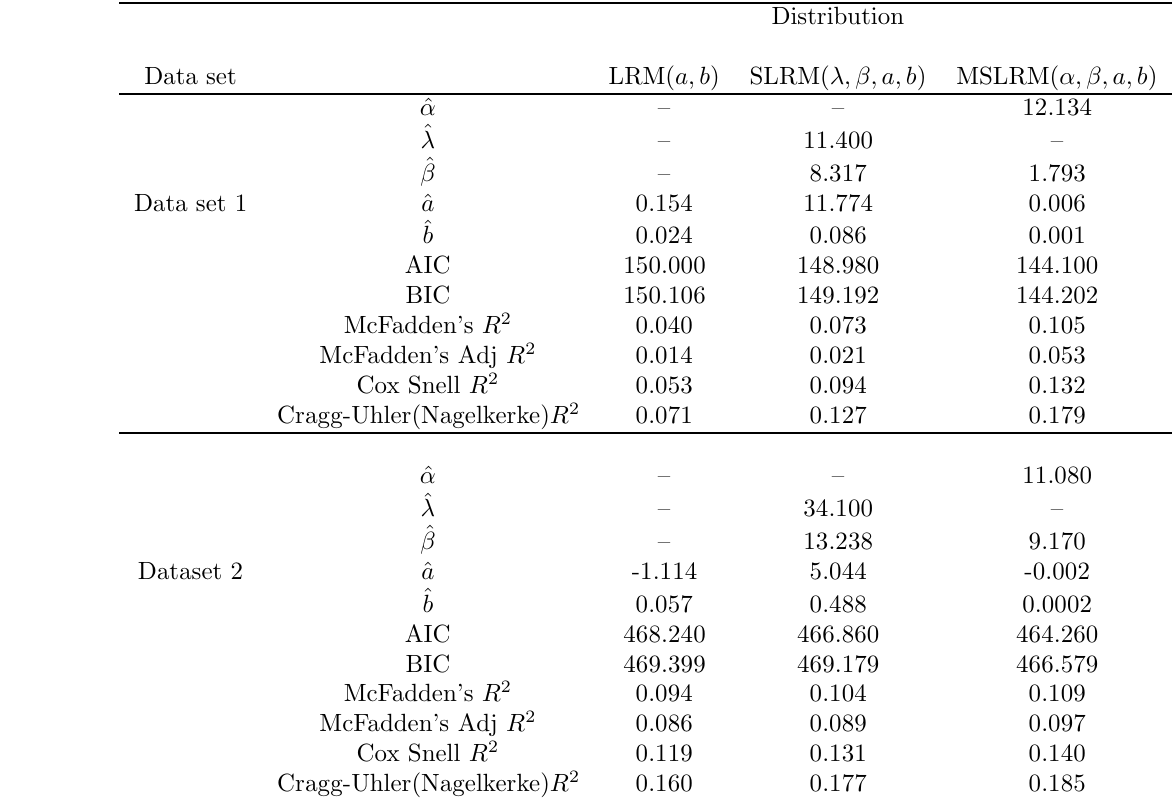
Estimated values of the parameters with the corresponding Pseudo R 2 values and Information criteria